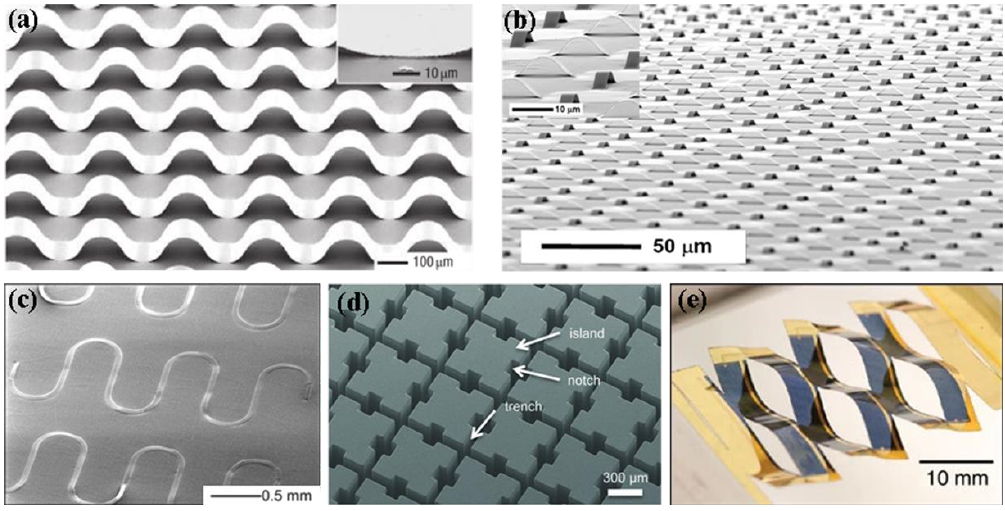
Figure 1. Structural engineering design model drawing: ( a ) buckling [20], ( b ) mesh [30], ( c ) serpentine [18], ( d ) islands [16], and ( e ) kirigami [31].